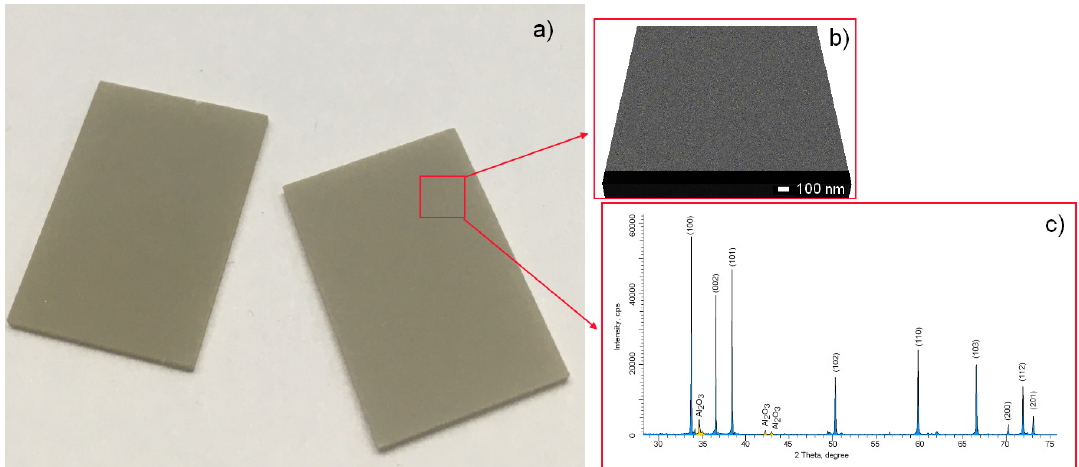
Figure 1. ( a ) Appearance of the original ceramics; ( b ) SEM image of the morphology of the original sample; ( с ) typical X-ray diffraction pattern of polycrystalline ceramic of aluminum nitride with a hexagonal type crystal lattice and impurity oxide inclusions.